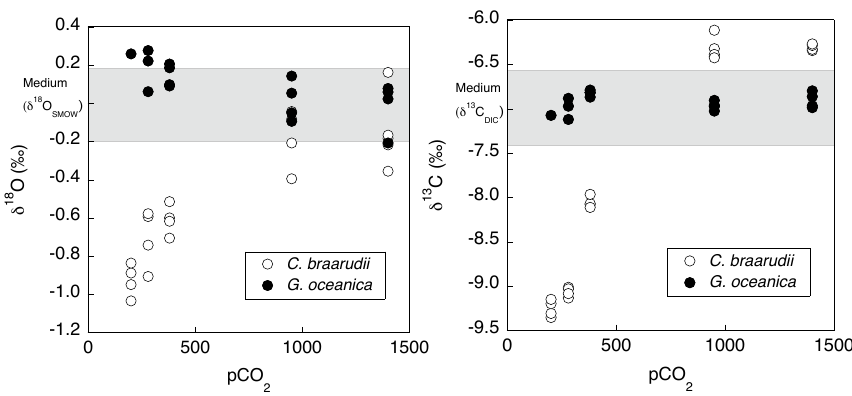
Fig. 5. The (left) δ 18 O and (right) δ 13 C in ‰PDB of the calcite liths of G. oceanica (black circles) and C. braarudii (open circles) compared to the δ 18 O SMOW composition estimated from average North Sea waters (Harwood et al., 2008), and the δ 13 C DIC as measured in the medium respectively with increasing p CO 2 . The grey box indicates the range in the estimated δ 18 O isotopic value of the North Sea Waters, and also the range in the δ 13 C DIC of the medium as measured at the beginning and end of each culture